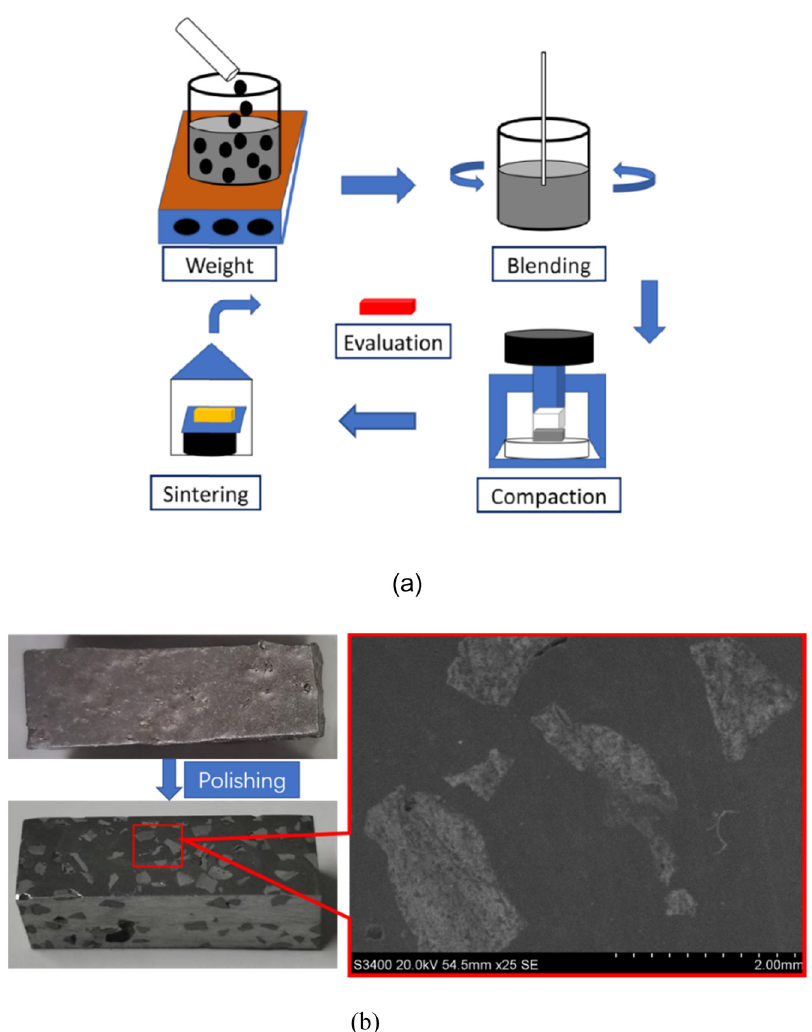
Figure 4: ( a ) The basic steps of preparing composite materials by powder metallurgy. ( b ) Sintered specimen and morphology.